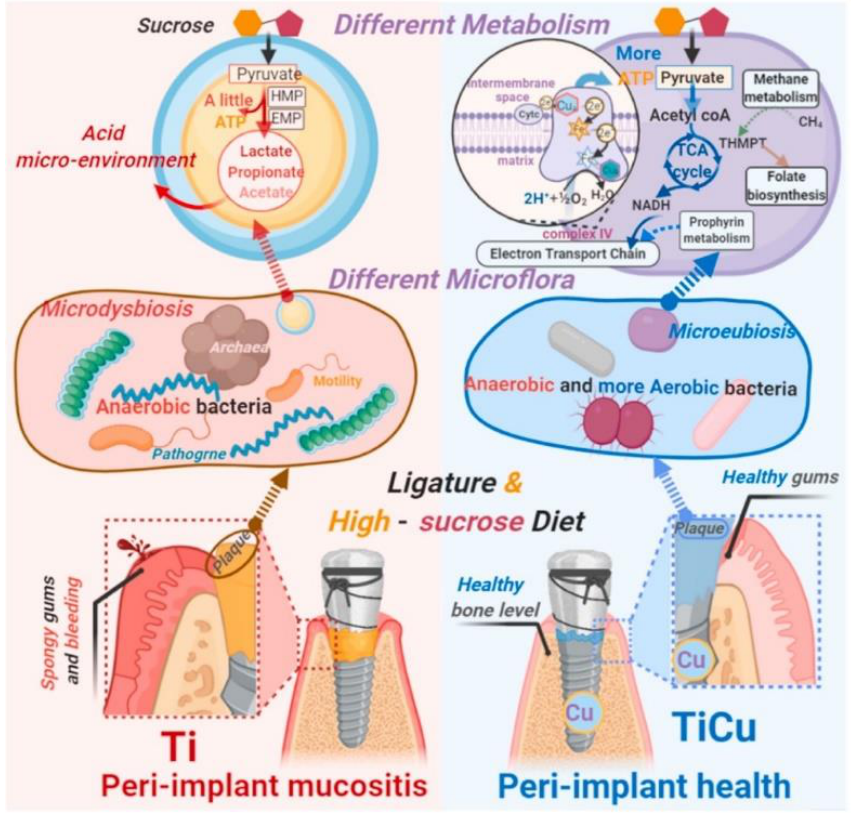
Figure 5. Schematic representation for anti-infective mechanism of TiCu implants in the ligature and sucrose-rich diet-induced model. Reproduced with permission from Ref. [38]. Copyright 2021, KeAi Publishing LTD.